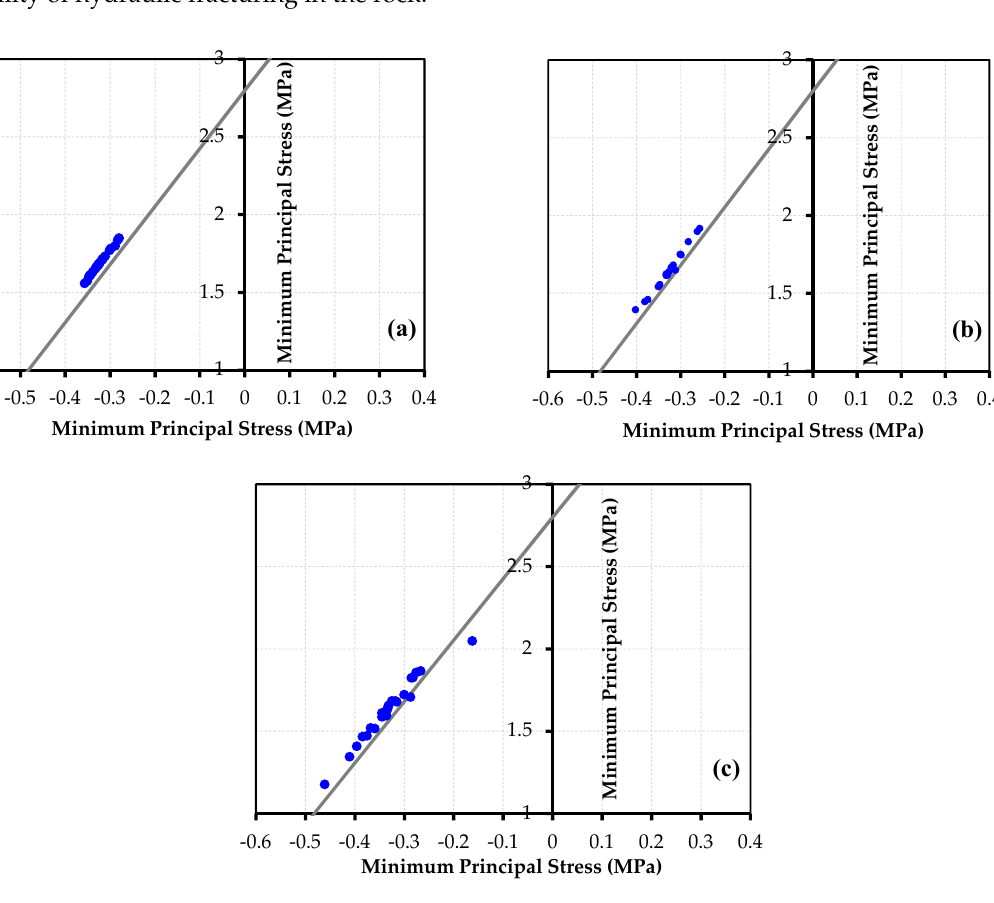
Figure 13. Stress in the elements by closing the gate in ( a ) 14 s, ( b ) 18 s, and ( c ) 26 s.